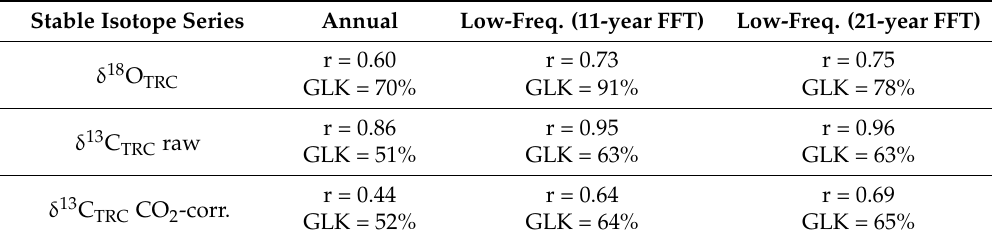
Table 2. Correlation coefficients (r) and Gleichläufigkeit (GLK) between stable carbon and oxygen isotope time-series of Juniperus tibetica and Picea balfouriana on different frequency scales for the common period 1685–2007. All given values are highly significant at p < 0.01. Stable Isotope Series Annual Low-Freq. (11-year FFT) Low-Freq. (21-year FFT) r = 0.60 r = 0.73 r = 0.75 δ 18 O TRC GLK = 70% GLK = 91% GLK = 78% r = 0.86 r = δ 13 C TRC raw